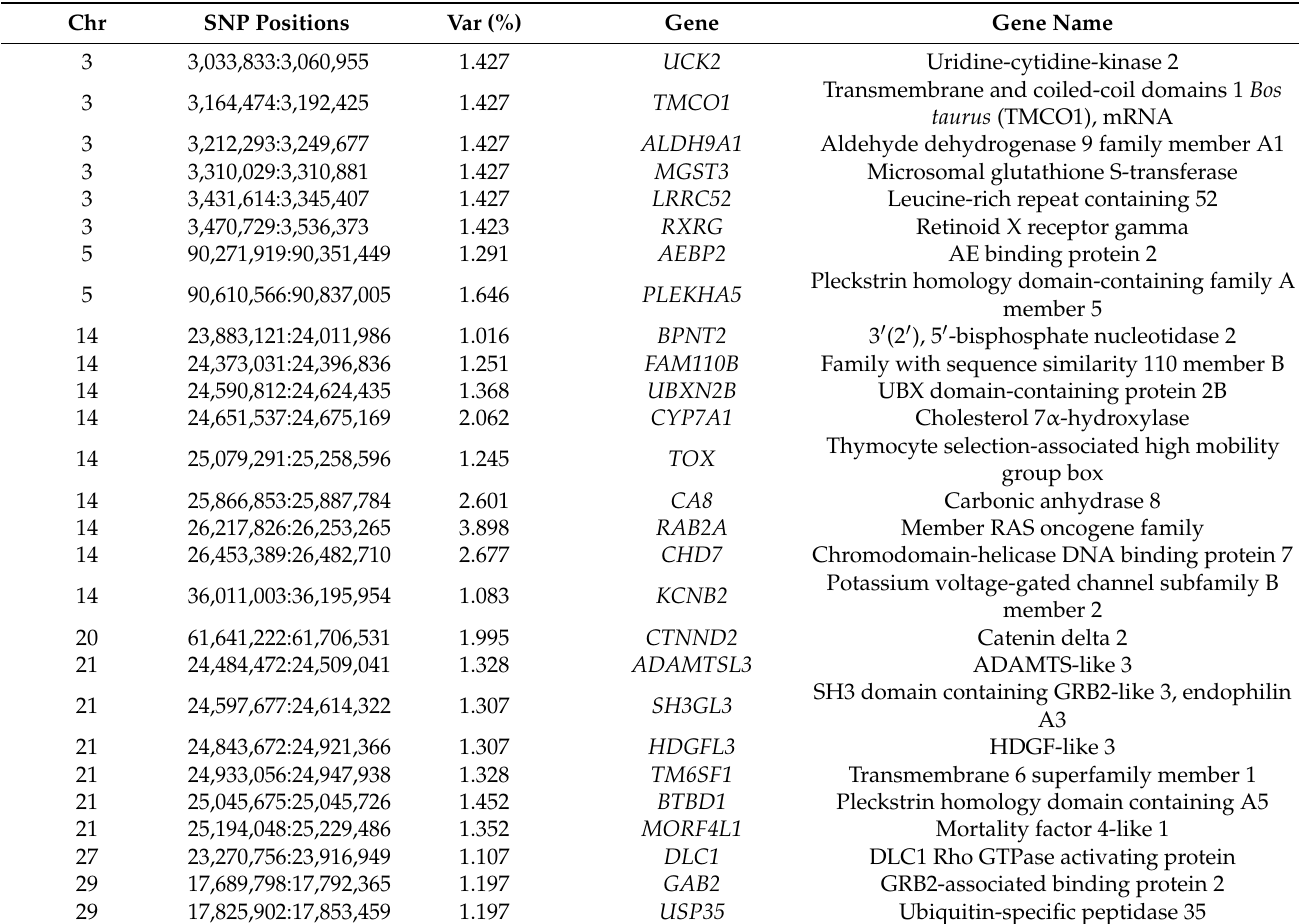
Table 2. Identification and description of genes located in windows associated with visual scores for conformation (CONF) that explained more than 1% of the additive genetic